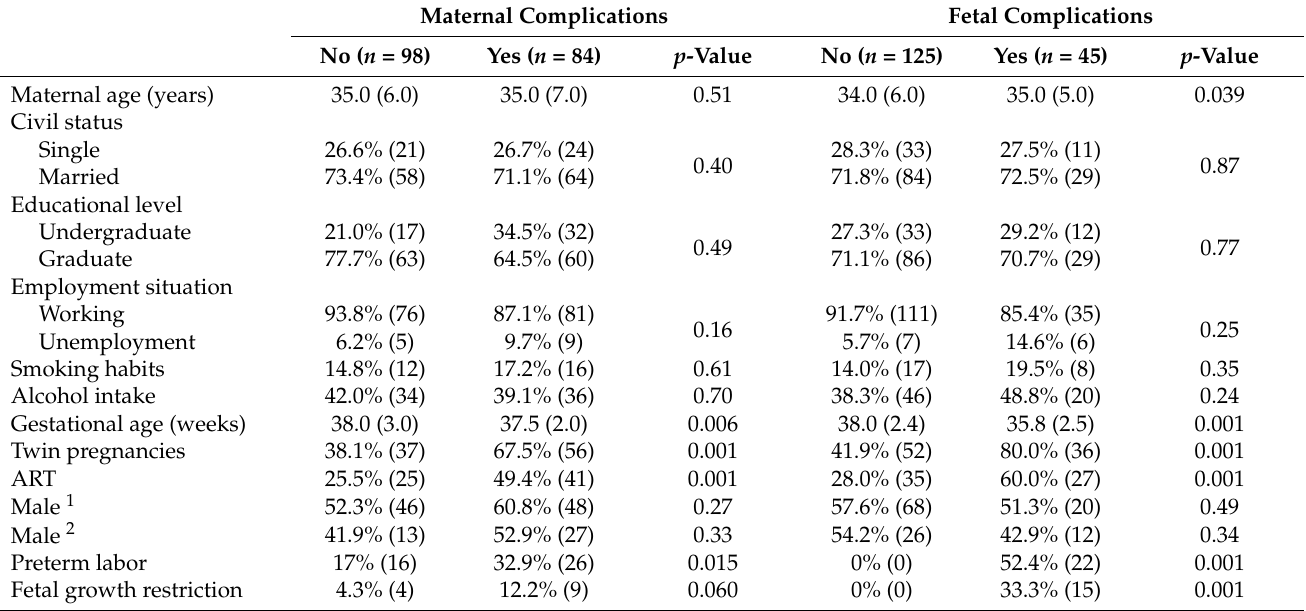
Table 2. Maternal characteristics according to maternal and fetal